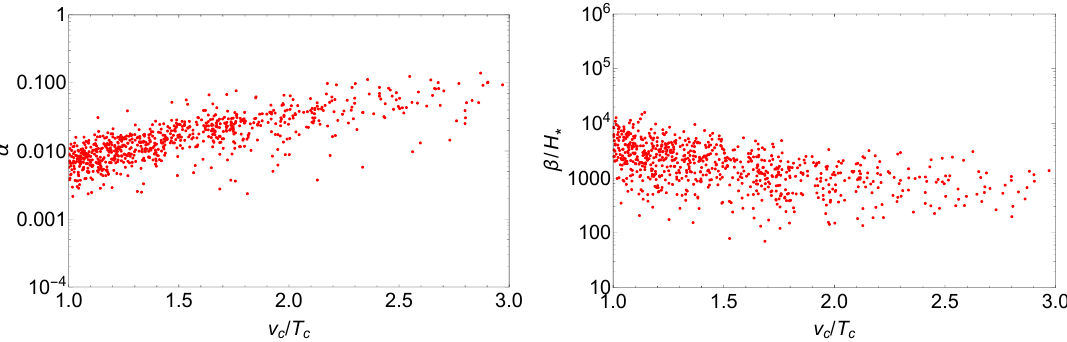
Figure 4 . The values of α (left) and β/H ∗ (right) for data points which have strong FOPT, as function of v . c /T c